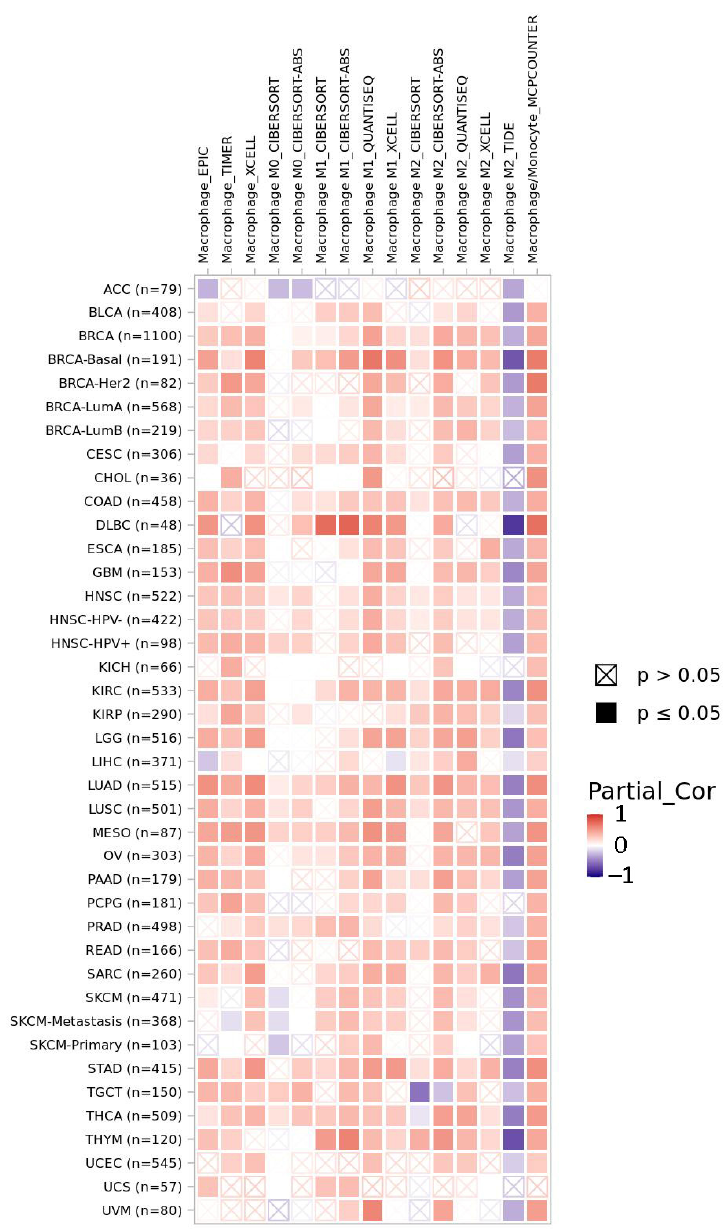
Figure 2. The correlations of LACTB expression with macrophage infiltration level are visualized in diverse cancer types by TIMER2.0. The heatmap shows the purity-adjusted spearman’s rho across various cancer types. Abbreviations: ACC, adenoid cystic carcinoma; BLCA, bladder urothelial carcinoma; BRCA, breast invasive carcinoma; CESC, cervical squamous cell carcinoma and endocer- vical adenocarcinoma; CHOL, cholangiocarcinoma; COAD, colon adenocarcinoma; DLBC, lymphoid neoplasm diffuse large B-cell lymphoma; ESCA, esophageal carcinoma; GBM, glioblastoma multi- forme; HNSC, head and neck squamous cell carcinoma; KICH, kidney chromophobe; KIRC, kidney renal clear-cell carcinoma; KIRP, kidney renal papillary cell carcinoma; LGG, brain lower-grade glioma; LIHC, liver hepatocellular carcinoma; LUAD, lung adenocarcinoma; LUSC, lung squamous cell carcinoma; MESO, mesothelioma; OV, ovarian serous cystadenocarcinoma; PAAD, pancreatic adenocarcinoma; PCPG, pheochromocytoma and paraganglioma; PRAD, prostate adenocarcinoma; READ, rectum adenocarcinoma; SARC ,sarcoma; SKCM, skin cutaneous melanoma; STAD, stomach adenocarcinoma; TGCT, testicular germ cell tumors; THCA, thyroid carcinoma; THYM, thymoma; UCEC, uterine corpus endometrial carcinoma; UCS, uterine carcinosarcoma; UVM, uveal mela- noma.